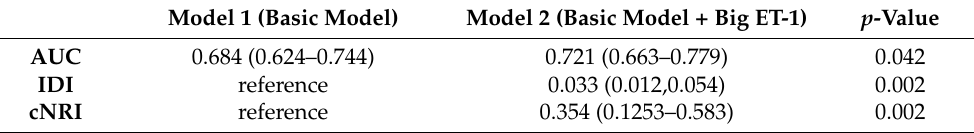
Table 3. Discrimination and reclassification of adding Big ET-1 to the model for LVRR.